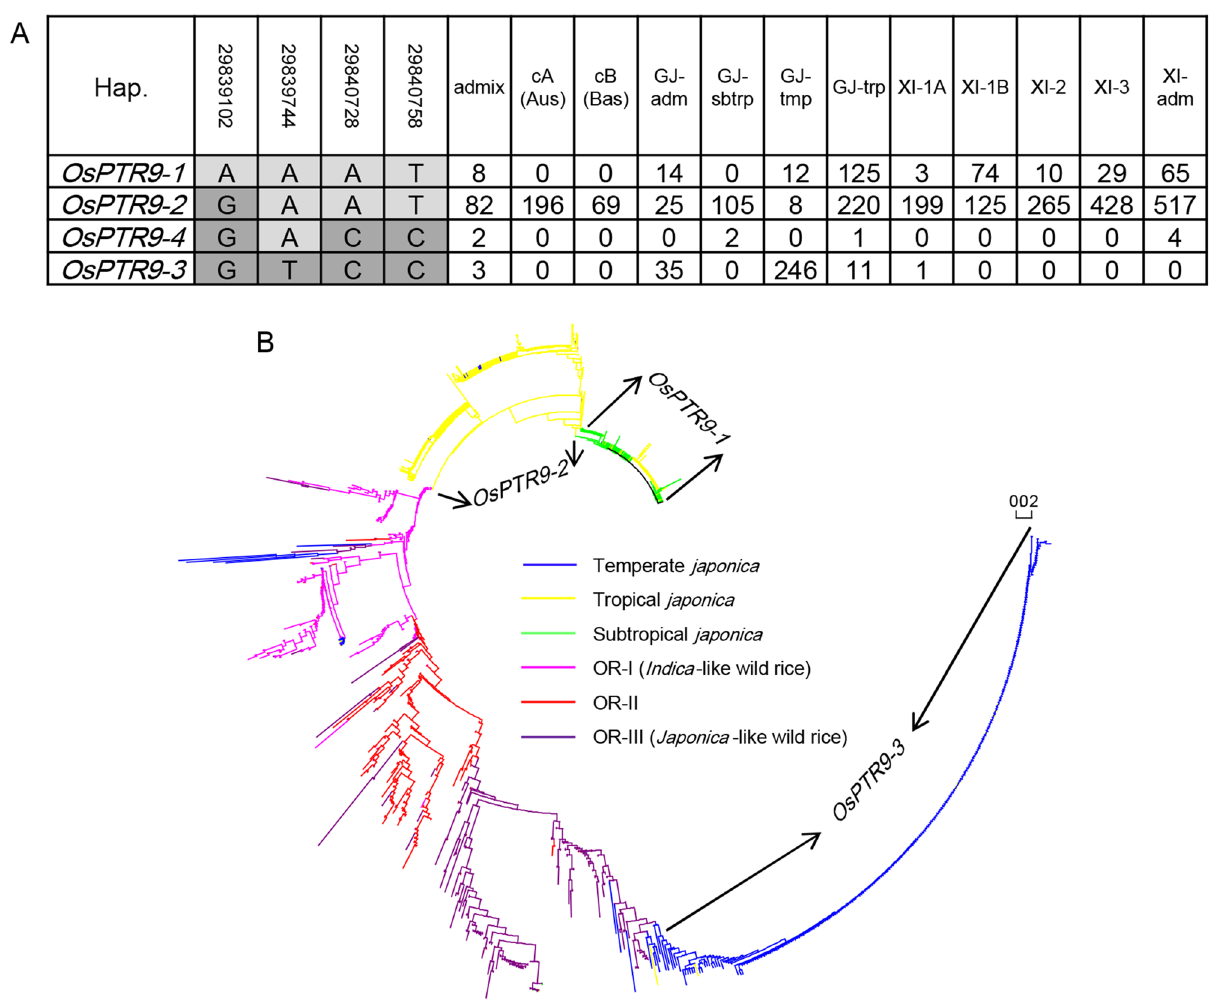
Figure 7. Domestication process of OsPTR9 . ( A ) Haplotype analysis and ( B ) phylogenetic relationship analysis using 3024 cultivated and 446 wild rice accessions. According to previous studies, XI-1A is indica subpopulation 1A, XI-1B is indica subpopulation 1B, XI-2 is indica subpopulation 2, XI-3 is i ndica subpopulation 3, XI-adm is indica admixed types between two or more XI subpopulations, GJ-adm is japonica admixed types between two or more GJ subpopulations, GJ-trp is japonica tropical subpopulation, GJ-sbtrp is japonica subtropical subpopulation, GJ-tmp japonica temperate subpopulation, cA or Aus is centrum-Aus population, cB or Bas is centrum-Basmati population and admix is admixed between any two or more of the XI, GJ, cA (Aus), cB (Bas)